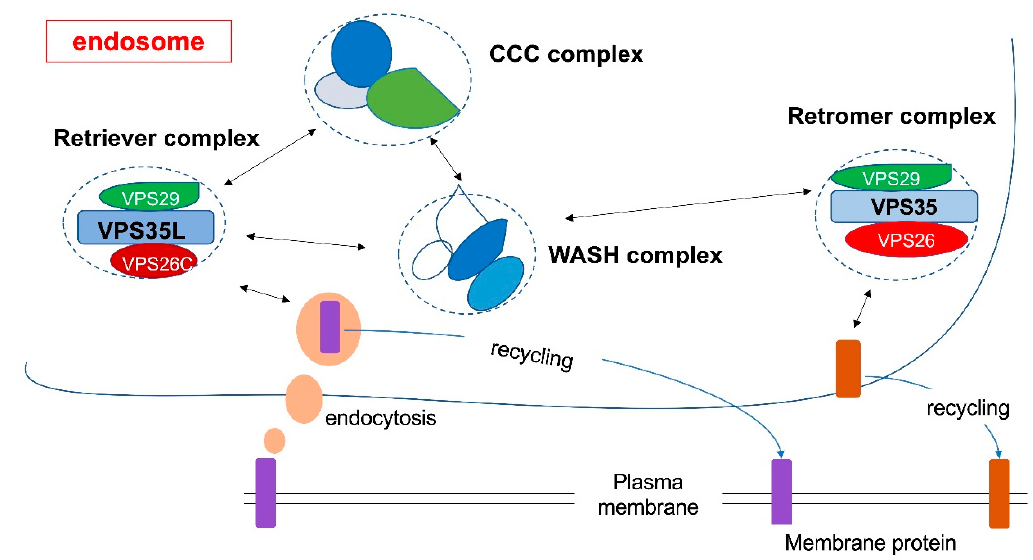
Figure 1. Schematic view of the endosome recycling system. Retromer and retriever complexes play a fundamental role in the recycling of numerous membrane proteins, although their target proteins are distinct. Retromer and retriever complexes interact with the WASH complex and the CCC complex for endosomal recycling (see text). WASH complex has an endosomal actin-remodeling function and is required for retromer and retriever to localize to the recycling endosome, while the CCC complex is shown to interact only with retriever.